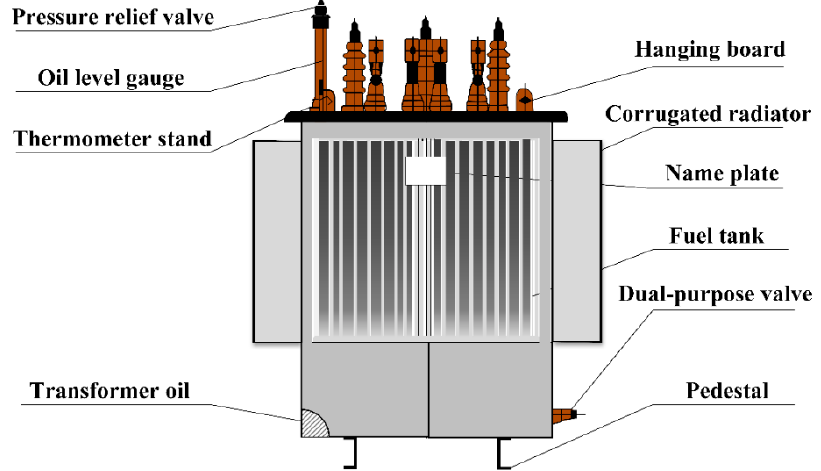
Figure 7. Design of S-M-315/10-NX2 distribution transformer.